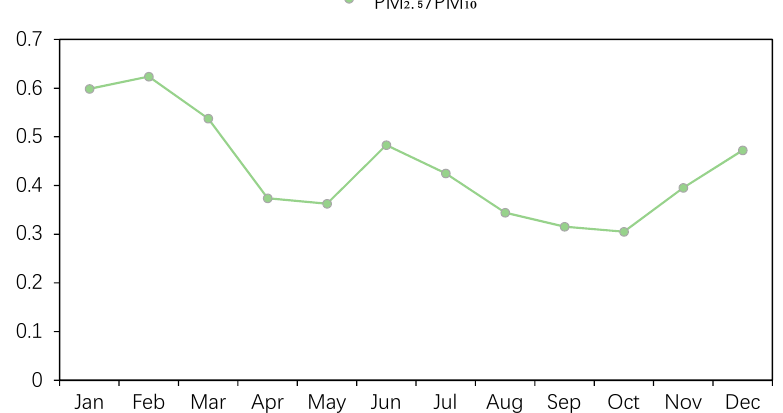
Figure 4. Variation in the PM 2.5 and PM 10 monthly average concentration ratios in Changchun in 2018.